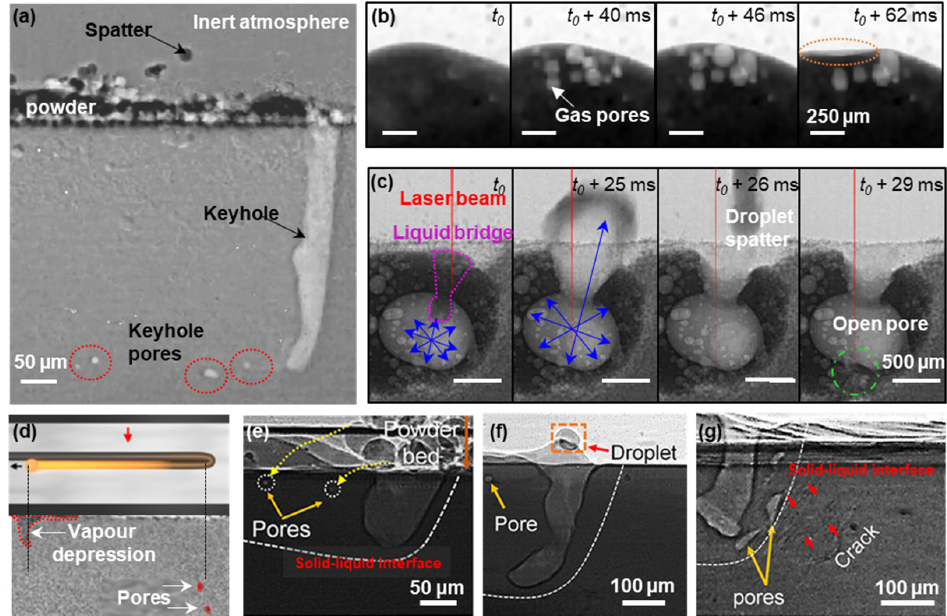
Figure 11. Radiographs captured during LPBF showing different types of pore formation mecha- nisms: ( a ) formation of keyhole pore due to unstable keyhole; ( b ) formation of gas pores due to reduction in gas solubility as the molten pool cools down (after [58]); ( c ) formation of open-pore due to pore bursting during multilayer laser remelting (after [153]); ( d ) formation of pores due to laser turning and acceleration/deceleration scan mirrors (after [155]); ( e ) pore transfer from powder feedstock to the molten pool (after [25]); ( f ) pore formation due to surface fluctuations (after [25]); and ( g ) pore growth from existing cracks (after [25]). Permitted for reuse from respective